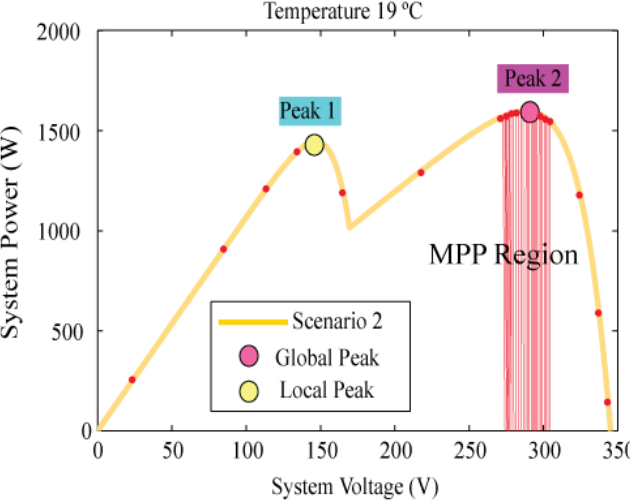
Figure 15. PV characteristics curve for scenario two.